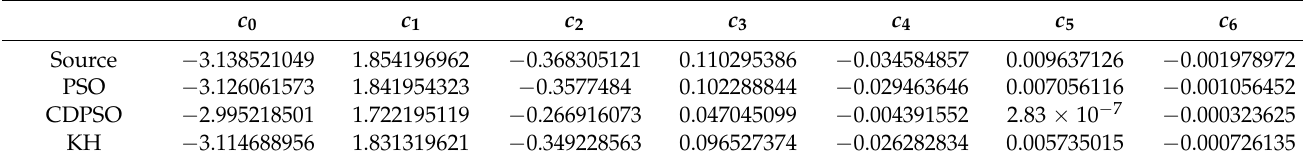
Table 5. Finite-difference coefficients of the second derivative optimized by PSO, CDPSO, and KH ( N = 12).